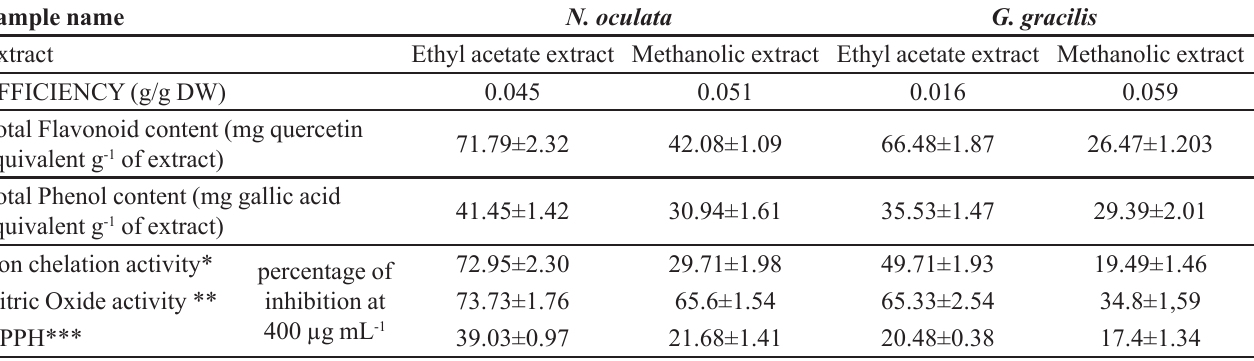
TABLE II -Total phenol and flavonoid contents and antioxidant activities of ethyl acetate and methanolic extract of N. oculata